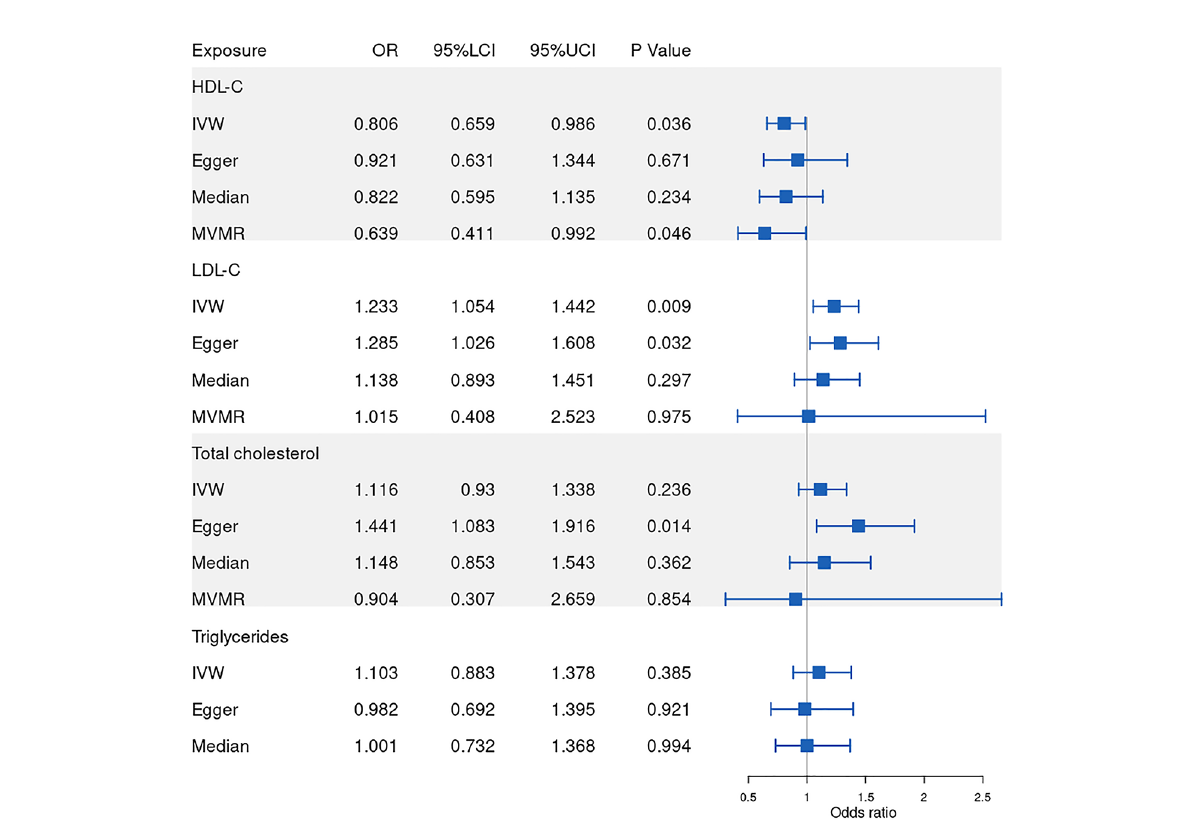
FIGURE 2 Forest plot of Mendelian randomization results from GLGC. IVW: inverse variance weighted, Egger: MR – Egger, Median: weighted-median, MVMR: multivariable mendelian randomization, 95%LCI: lower limit of 95% CI, 95%UCI: upper limit of 95% CI. GLGC, Global Lipids Genetics